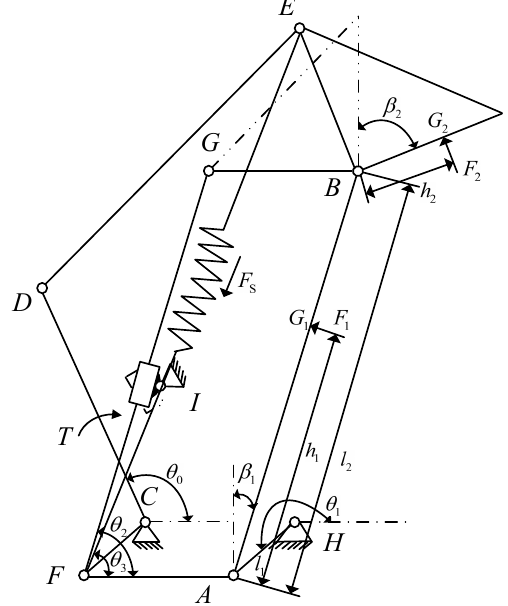
Figure 8. Contact force diagram of the finger mechanism.